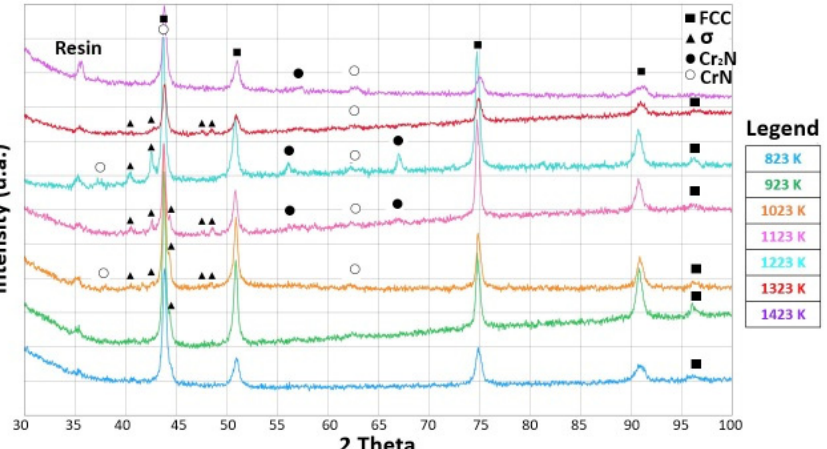
Figure 8. XRDs of cold-rolled and annealed samples at temperatures between 823 K and 1423 K. Temperature is increasing in 100 K steps, bottom up. The sequence is: 823 K (blue), 923 K (green), 1023 K (orange), 1123 K (pink), 1223 K (light blue), 1323 K (red), 1423 K (magenta). Peaks are due to resin, FCC Cantor’s alloy (card number 00-033-0397), σ phase (card number 00-005-0708), Cr 2 N (card number 00-035-0803), CrN (card number 00-011-0065).